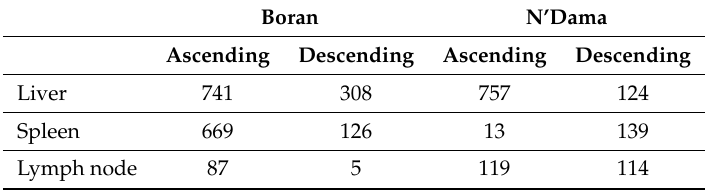
Numbers of statistically significant Monotonically Expressed Genes in ascending and descending order for liver-, spleen- and lymph node-tissues for the cattle breeds Boran and